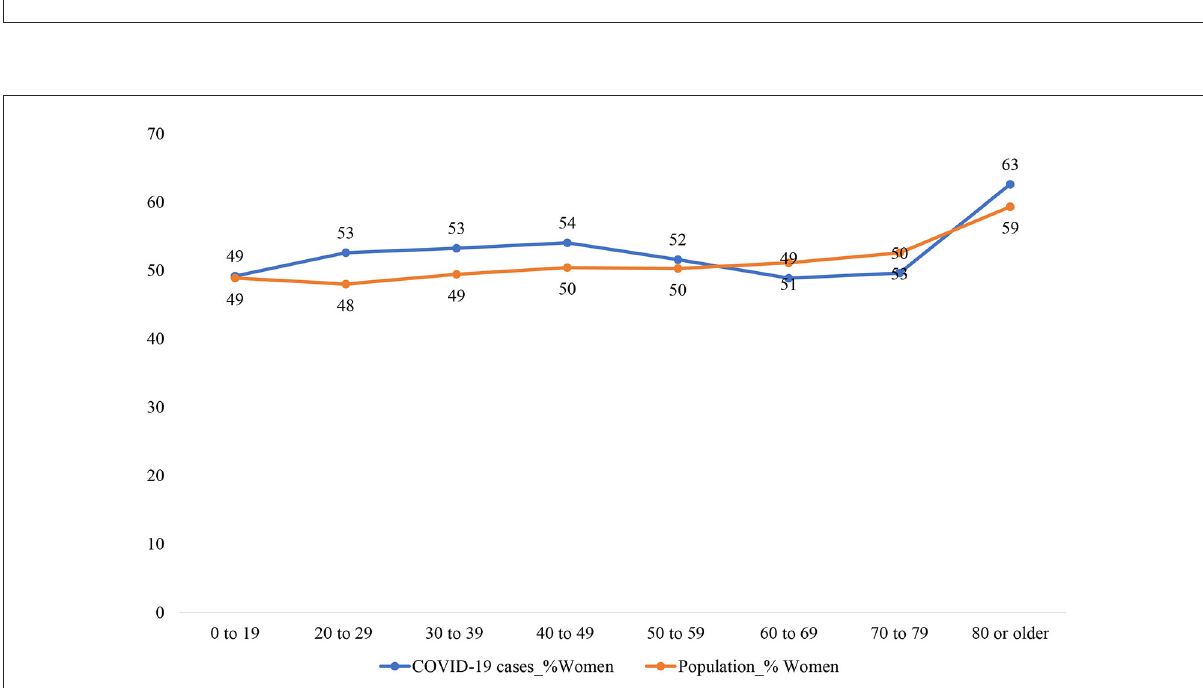
FIGURE1 Gender distribution of COVID-19 infections by age group (A) and occupation (B) . The share of cases in each age group or occupation is indicated by the percentage in parentheses.